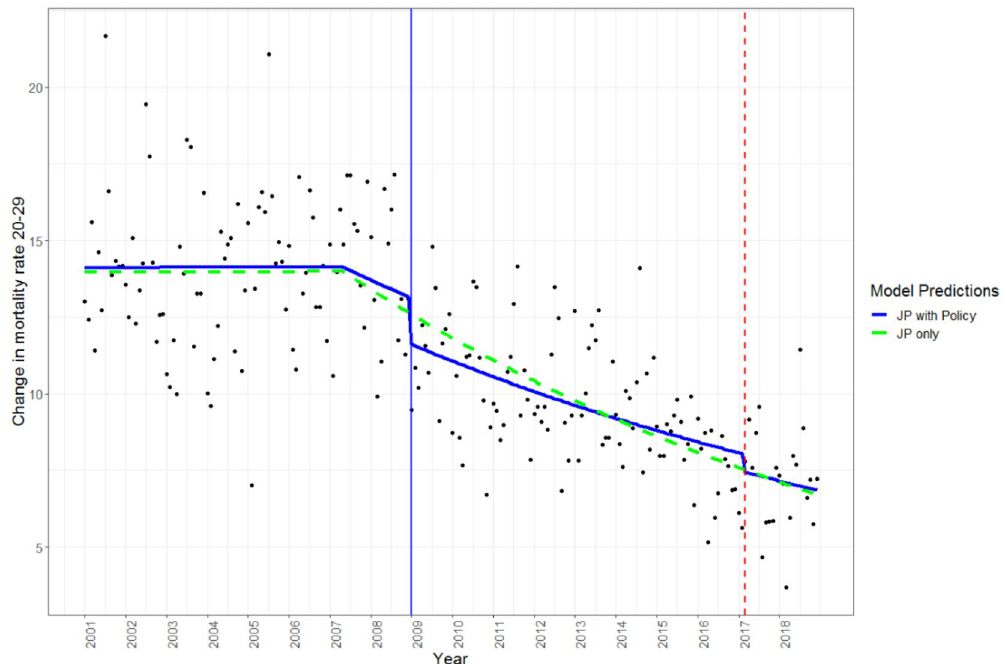
Figure 2. Scatterplot trend of mortality rate (deaths per 100,000 people) for ages 20–29. Joinpoint (JP) modeled with and without policy effects. Alcohol control policy implemented in 2009 (increased taxation and reduced availability) and 2017 (increased taxation) shown by the solid blue line and dashed red line,